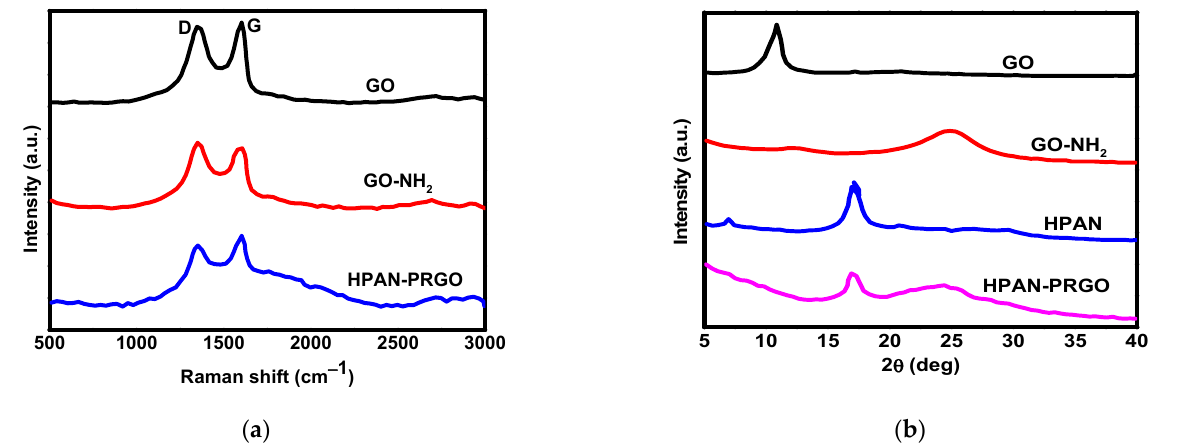
Figure 3. Raman spectra ( a ) and XRD ( b ) of synthesized materials. FT-IR spectra of synthesized materials including HPAN-PRGO, HPAN, PAN-PRGO, PAN, GO-NH 2 , and GO are shown in Figure 4a,b to approve their formation. The FT-IR of GO showed several peaks that corresponded to various functional oxygen groups, such as epoxy and alkoxy stretching, that appeared at 1158 and 1082 cm − 1 , respectively [34,35]; hydroxyl groups stretching vibrations appeared as a wide band at 3337 cm − 1 , and the carbonyl of the carboxylic group appeared at 1732 cm − 1 [35]. The FT-IR spectra of amino- functionalized GO showed two new peaks, for N–H bending that appeared at 1652 cm − 1 , and N–H stretching that was represented at 3273 cm − 1 [36]. These bands show that the amine group and the amide linkage effectively functionalized graphene oxide with ethylene diamine. The characteristic peaks of PAN that appeared at 1460 and 2921 cm − 1 represented CH 2 bending and stretching vibrations, while the nitrile stretching vibration was represented by the peak at 2238 cm − 1 [37]. Additionally, the nitrile group was confirmed by the peak at 1644 cm − 1 . The FT-IR spectra of PAN-PRGO showed a peak at 2921 cm − 1 , as in PAN, that corresponded to CH 2 stretching vibration, and a peak corresponding to a nitrile group at 2239 cm − 1 . Additionally, the formation of N–C=N or NH–CO due to the interaction between AN nitrile groups and amino-functionalized GO was confirmed by the appearance of a new peak corresponding to an amide group at 1574 cm − 1 , and the disappearance of or reduction in the amino-functionalized GO peaks at 1652 and 3273 cm − 1 . Additionally, NH–C=N–CH 2 formation was represented by the peaks at 1219 and 1460 cm − 1 . The FT-IR of PAN partially hydrolyzed using sodium hydroxide showed peaks at 1667 and 1574 cm − 1 , corresponding to amino and carbonyl stretching bands, and a reduced band at 2239 cm − 1 after hydrolysis. The HPAN-PRGO FTIR spectra showed two new peaks at 1667 and 1574 cm − 1 confirming the occurrence of hydrolysis. Additionally, the nitrile group band at 2239 cm − 1 completely disappeared, while two overlapped peaks corresponding to COONa and N–H were observed at 1574 and 1667 cm − 1 . The GO was confirmed to be partially reduced by the reduction in the epoxy group peak at 1082 cm − 1 . Thus, these results demonstrate that aminated GO was successfully produced, and that AN was simultaneously implanted and polymerized at the amino group of functionalized GO during the polymerization process, yielding covalently hybrid-prepared (HPAN-PRGO) nanocomposite. To determine the enhanced surface area of synthesized nanocomposite, the N 2 adsorption–desorption isotherm of synthesized materials was performed and is shown in Figure 4c. The surface areas of HPAN, GO-NH 2 , and HPAN-PRGO were 27.0, 36.3, and 58.0 m 2 /g, respectively. The effect of modification on the surface area is clear from the isotherm curve that further affects the adsorption capacities toward the uptake of Sm 3+